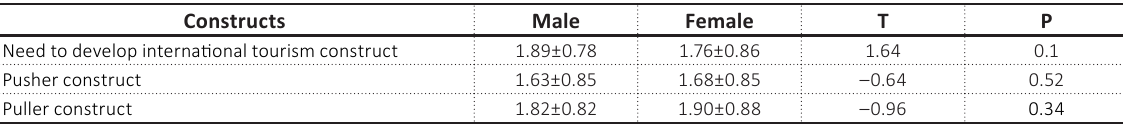
Table 7. Gender difference